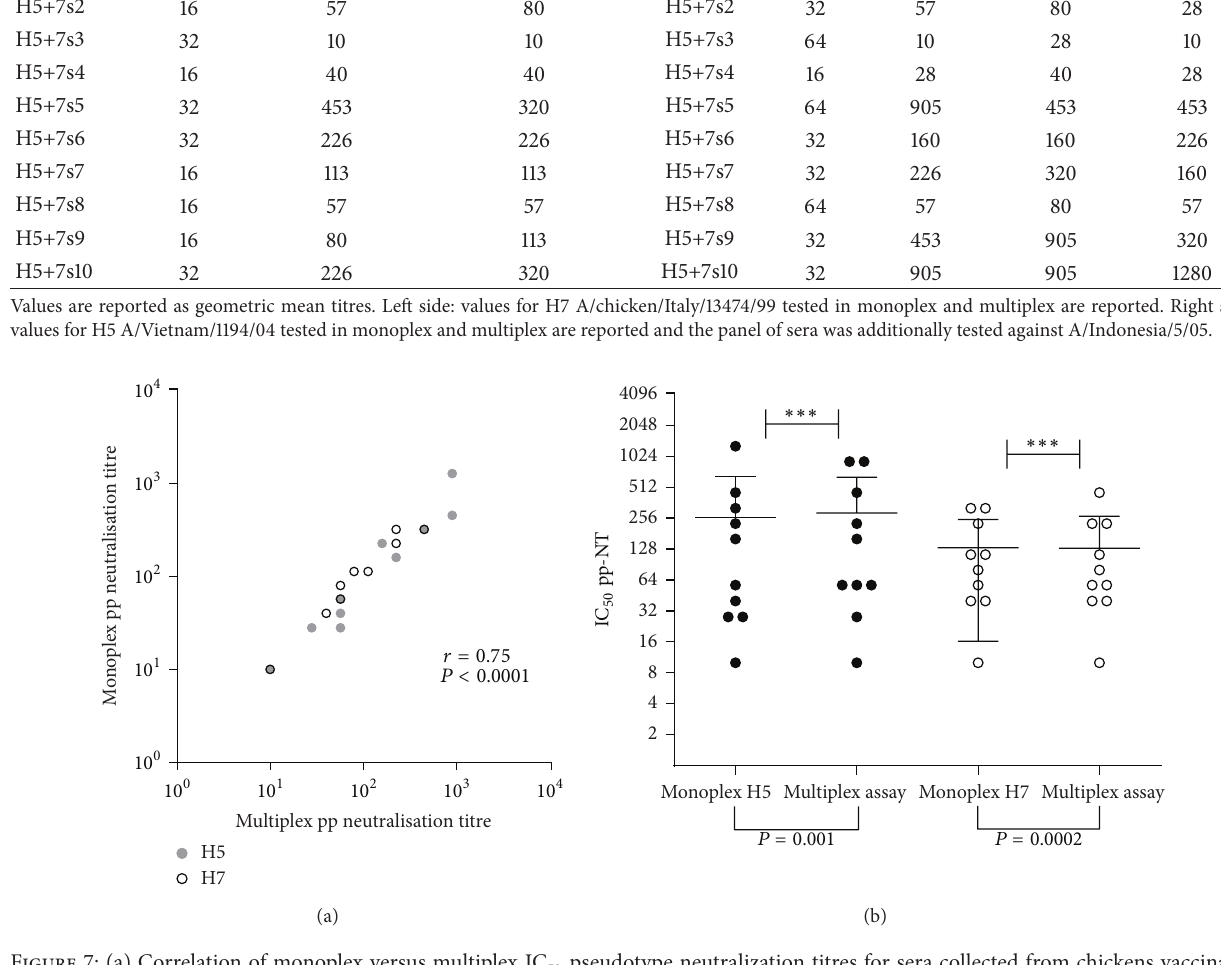
Figure 7: (a) Correlation of monoplex versus multiplex IC 50 pseudotype neutralization titres for sera collected from chickens vaccinated with an inactivated bivalent vaccine produced with the AI strains H7N1 (A/ck/Italy/1067/99, LPAI) and H5N9 (A/ck/Italy/22A/98, LPAI). Antibody titres between monoplex and multiplex assays correlate when tested with both H5 and H7 pseudotypes. Neutralizing titres against H5 A/Vietnam/1194/2004 (grey dots) and H7 A/chicken/Italy/13474/1999 (empty circles) were determined in separate wells (single) or in the same well (multiplex). Correlation coefficient and 𝑃 values were calculated using Pearson’s correlation. Plot drawn with GraphPad. (b) IC 50 values for each sera tested by monoplex and multiplex pp-NT assays using H5 A/Vietnam/1194/04 (firefly luciferase gene) and H7 A/chicken/Itlay/13474/1999 (carrying firefly luciferase and Renilla luciferase gene) were calculated and plotted (the wide horizontal bar represents the means of IC 50 titres). Results were subsequently analyzed by performing Student’s 𝑡 -test on the paired